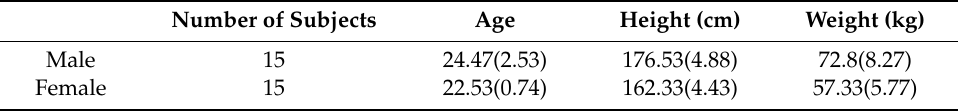
Table 1. General characteristics of